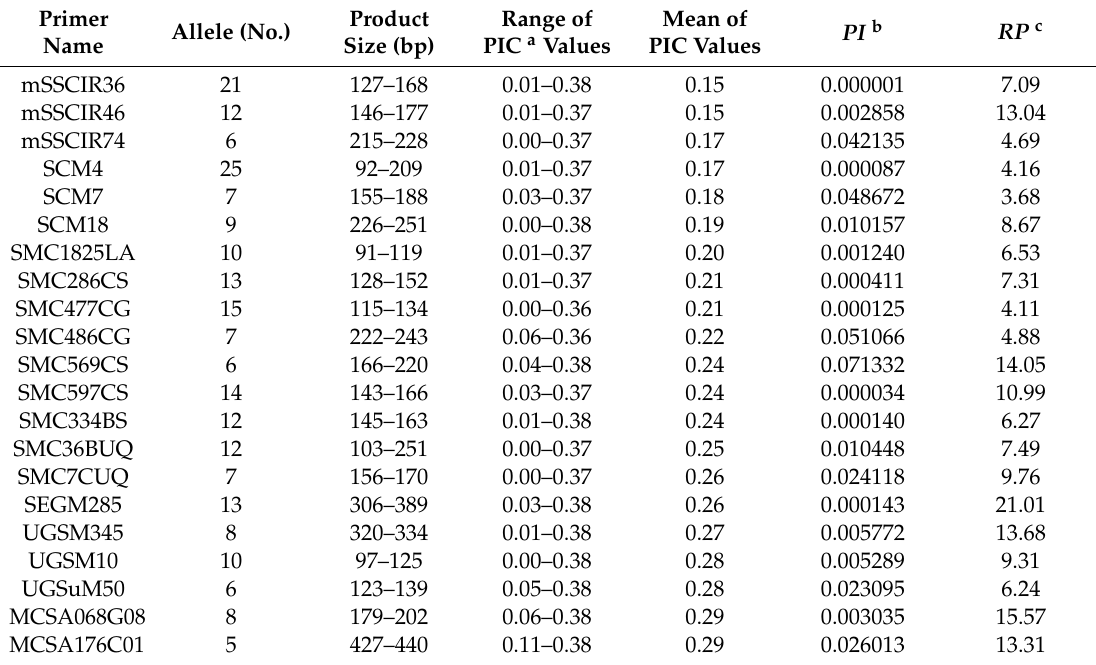
Table 3. Genetic diversity parameters of 150 of the most popular parental clones from sugarcane hybrid breeding